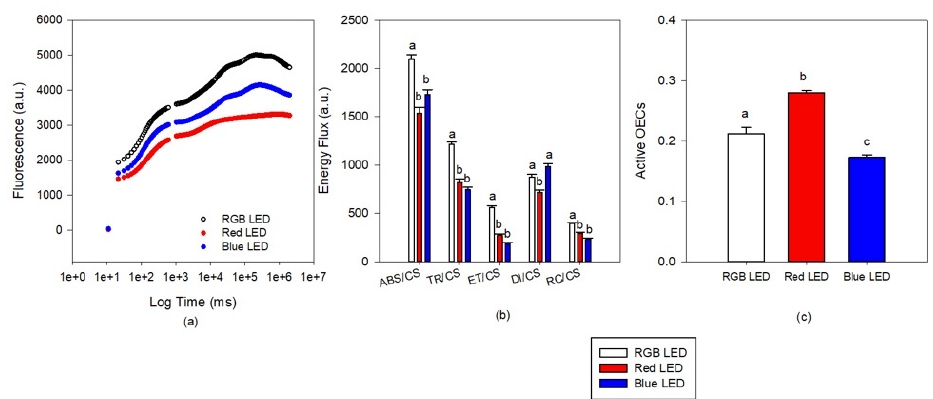
Figure 3. Kautsky transient light curves ( a ), phenomological energy fluxes (( b ), absorbed (ABS/CS), trapped (TR/CS), transported (ET/CS) and dissipated (DI/CS) energy fluxes and oxidized reaction centers (RC/CS) and active oxygen evolving complexes ( c ) in the P. tricornutum cultures (N = 5) subjected to the three light treatments at the end of the 96 h exposure period (average ± standard error, letters denote significant differences between light treatments at p < 0.05).